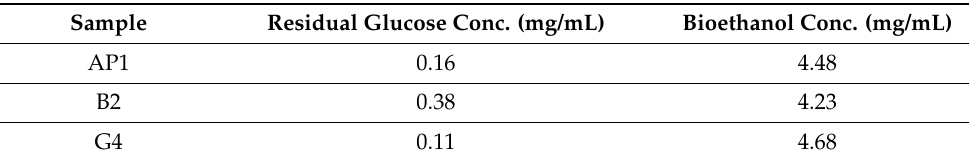
Table 1. The concentration of bioethanol produced by Ap1, B2, and G4 yeast isolates after 72 h of anaerobic incubation in YPG broth.